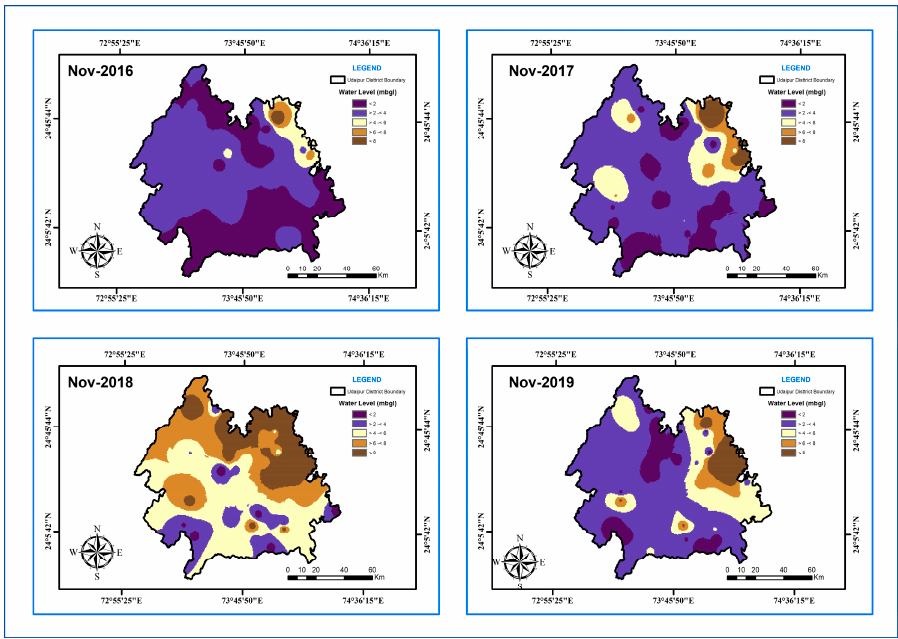
Figure 10. The water-level distribution of during post-monsoon season in the Udaipur district.